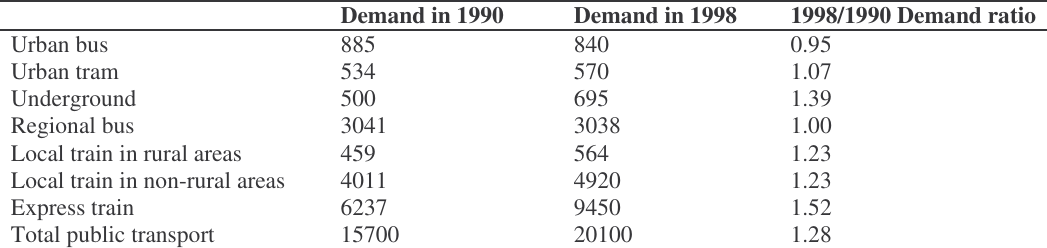
Table 4. Demand for the Dutch public transport systems (mln passenger km) Demand in 1990